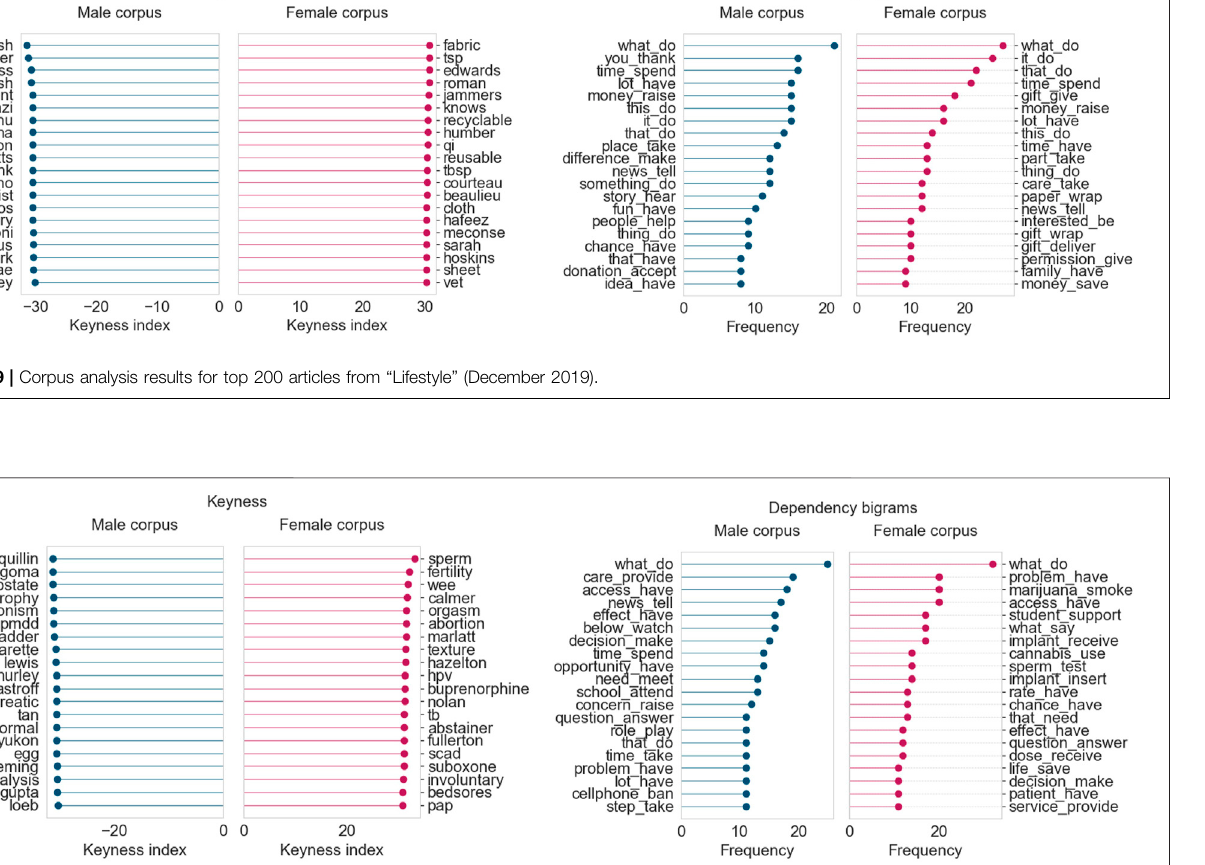
FIGURE 10 | Corpus analysis results for top 200 articles from “ Healthcare and medical research ” (March